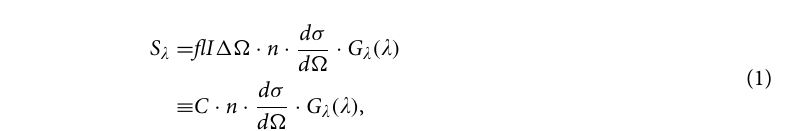
Figure 5. The obtained Raman signal of air, captured using 3000 exposures while the plasma jet and argon flow was inactive. Fitting of the binned spectrum as shown in the right graph allowed to obtain the calibration constant C from Eq.